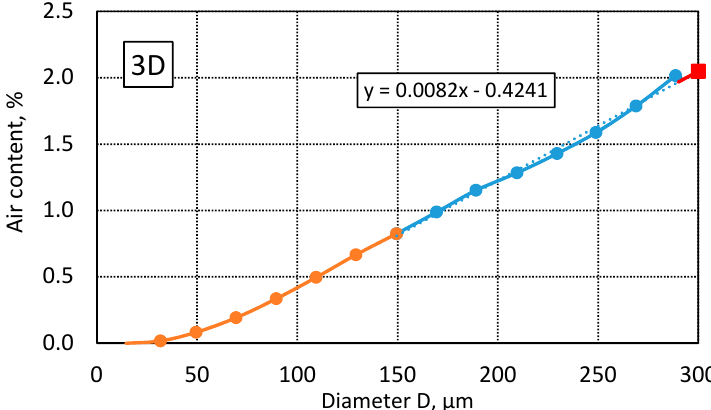
Figure 3. Method of determining micro-air content A 300 . Table 1. Results of calculations with the use of the VBA macro in MS Excel.